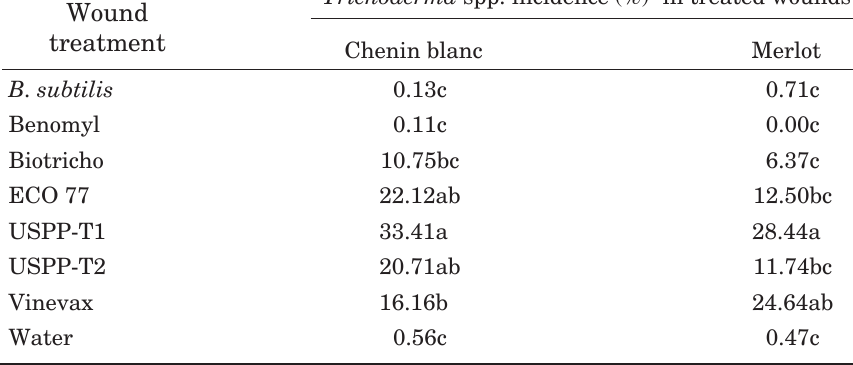
a Means followed by the same letter do not differ significantly ( P <0.05;